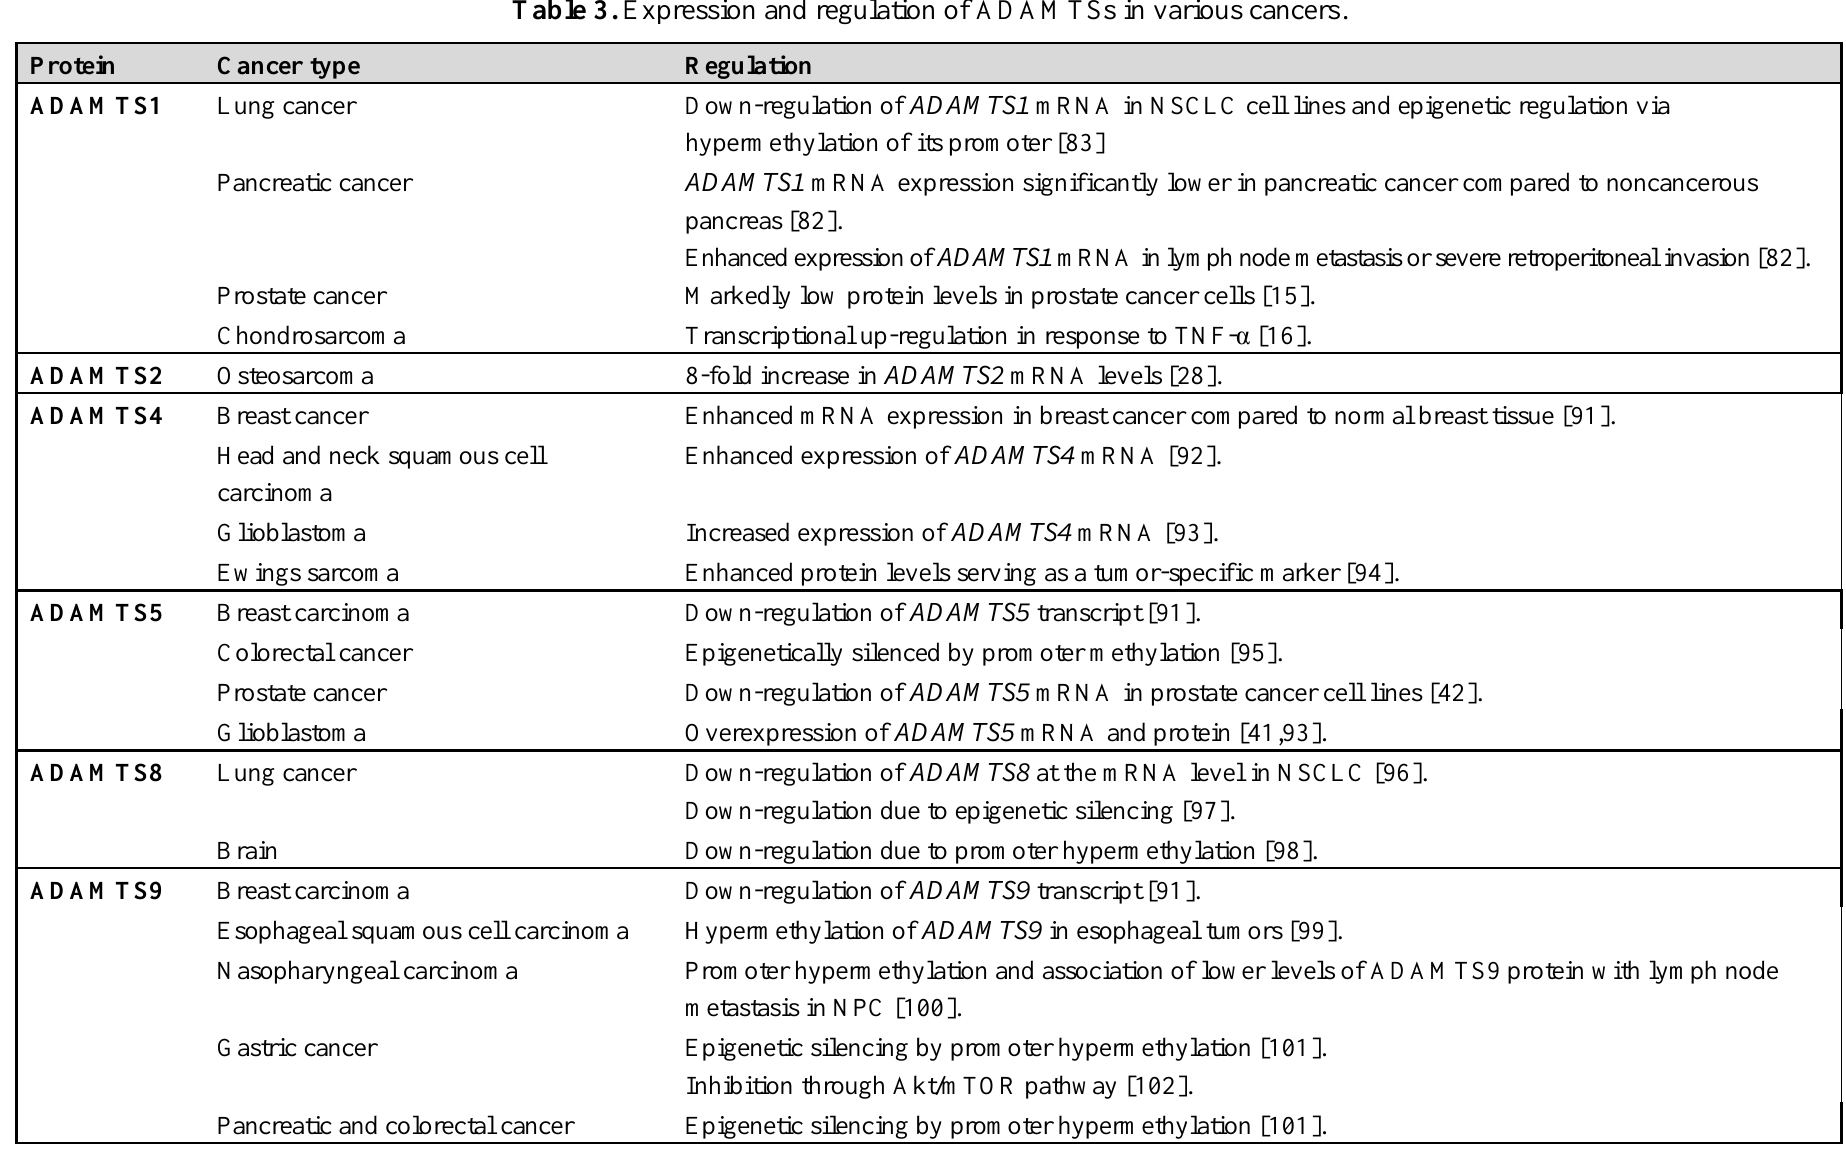
Table 3. Expression and regulation of ADAMTSs in various